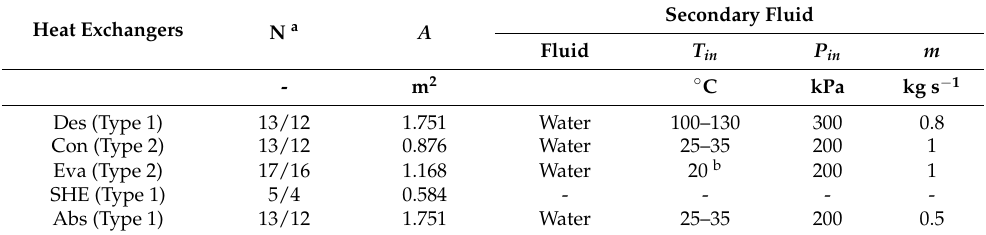
Table 5. Input parameters of the heat exchangers and secondary fluids for above-zero refrigeration. Heat Exchangers N